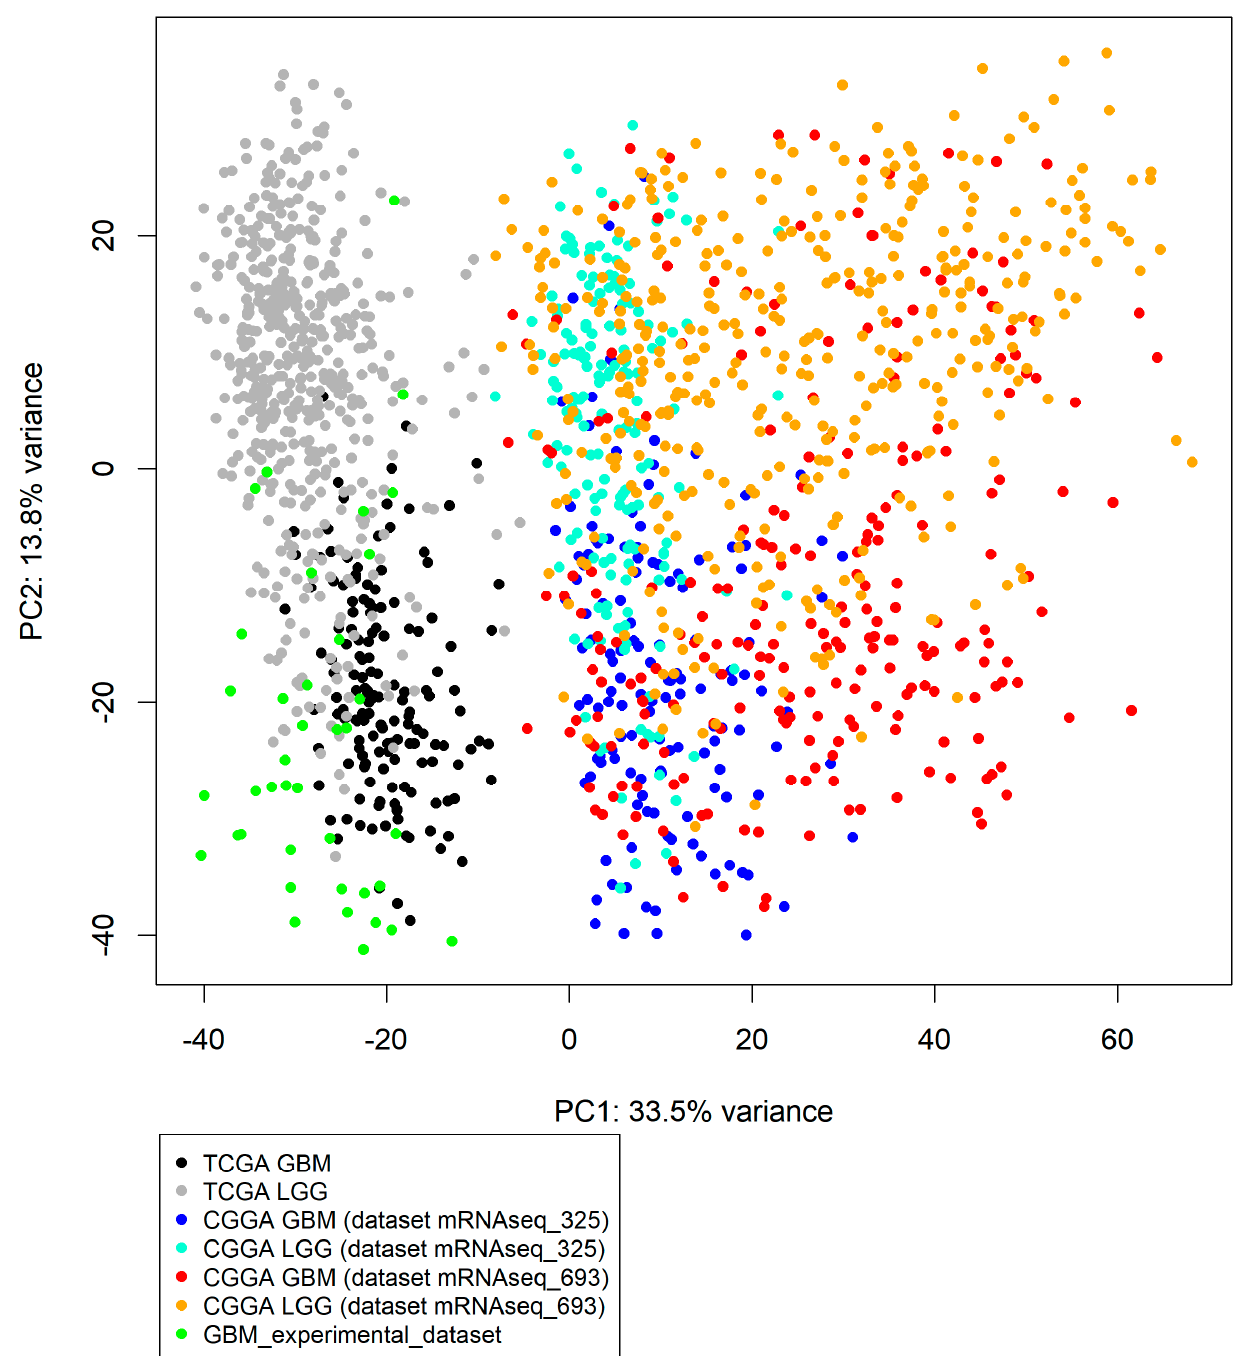
Figure 1. Principle component analysis (PCA) plot built for primary gene expression data of three literature datasets for LGG, tree literature datasets for GBM, and one experimental dataset for GBM samples. PCA plot was built using prcomp function from stats R package [35].